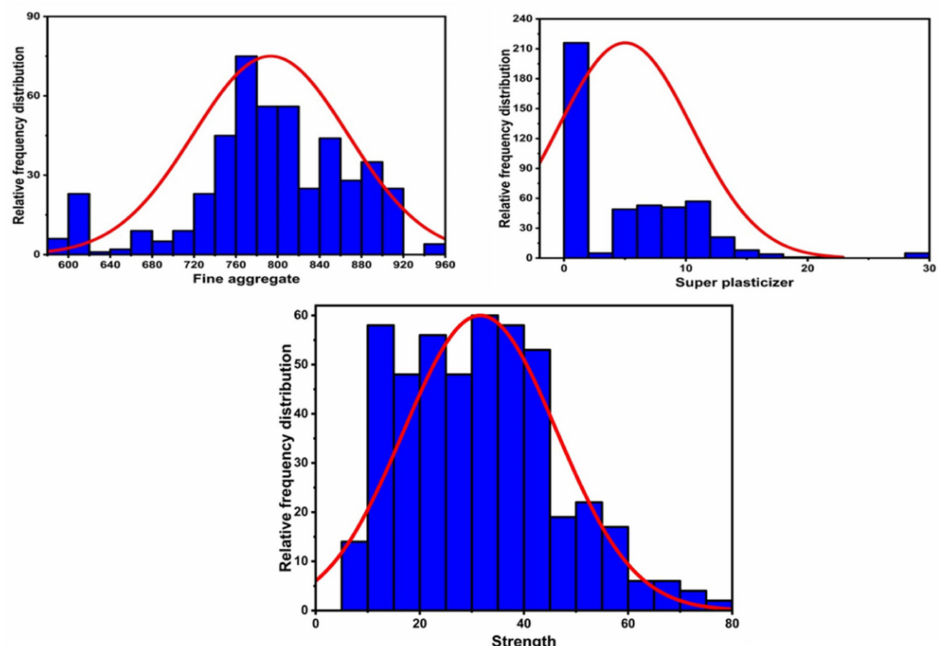
Figure 2. Relative frequency distribution of variables.